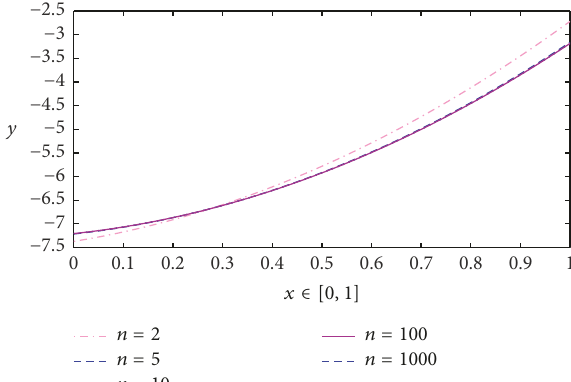
Figure 2: The difference 𝐷 0.8,0.3 𝑛,𝛼,𝛽 (𝑓,𝑥) − 𝑓(𝑥) for 𝛼 = 0 , 𝛽 = 0 , and 𝑓(𝑥) = 9 − 6𝑥 − 3𝑥 2 .